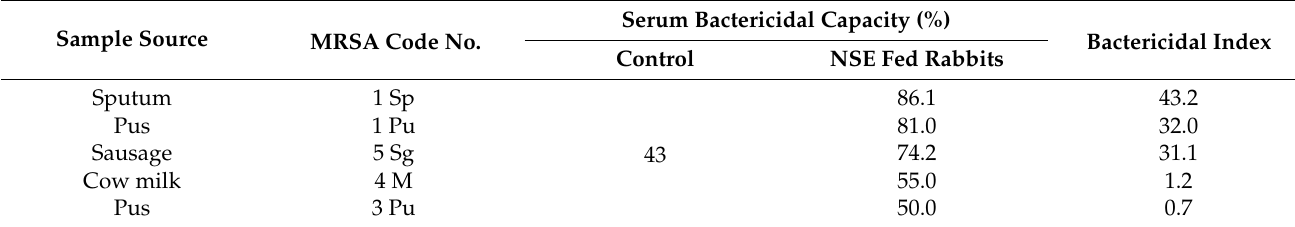
Table 6. Bactericidal activity of sera of NSE fed rabbits against MRSA